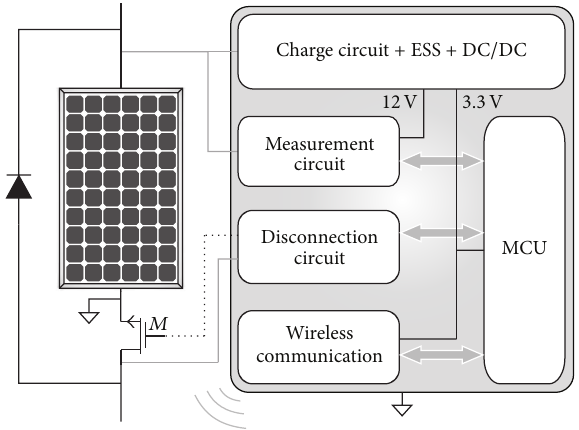
Figure 4: Schematic block diagram of the disconnection circuit.